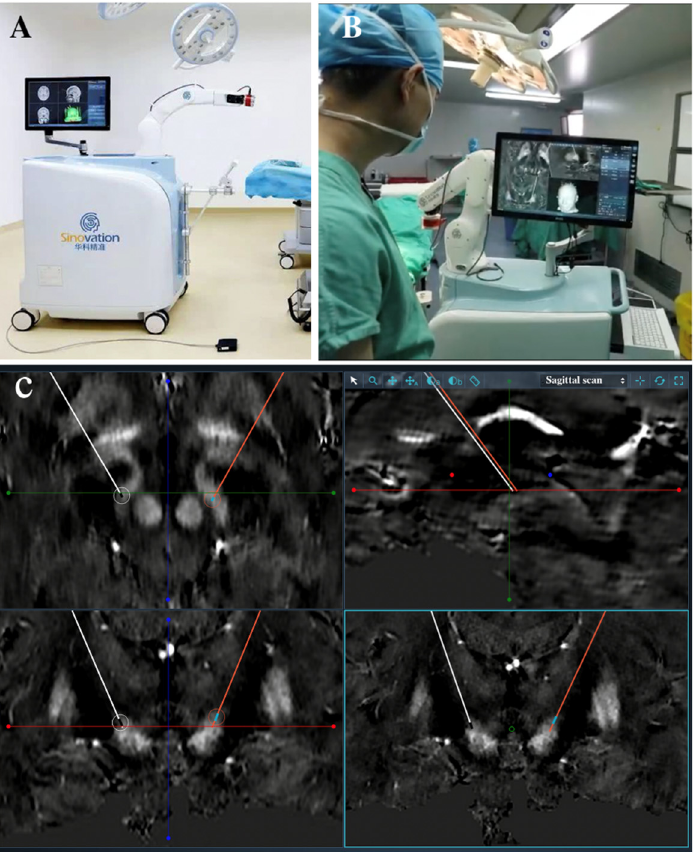
Figure 1. ( A , B ) The Sinovation SR1 robot is composed of a robot arm, computer control system, and display system. ( C ) Bilateral trajectories were designed to pass through the subthalamic nucleus (STN) on the Sinoplan 2.0 planning software (Sinovation).